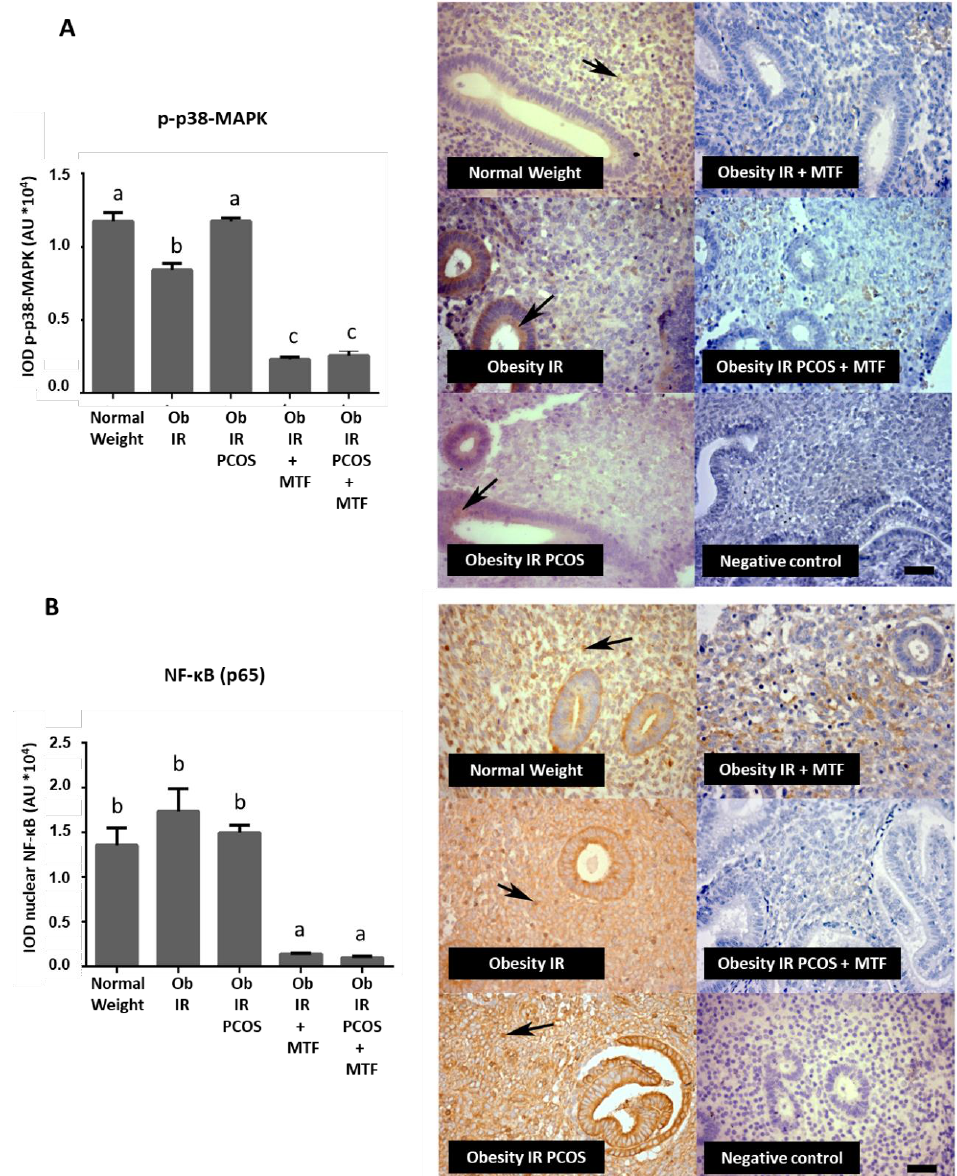
Figure 3. Effect of metformin on expression levels of p38-MAPK in its active form and NF-κB in the endometria of women with insulin resistance, obesity and PCOS. p-p38-MAPK (T180/Y182) protein (active form) ( A ) and NF-κB (p65 subunit) protein ( B ) levels in endometria from the study groups were determined by IHC ( n = 7 samples in each group): Normal Weight group (control group), Obesity+IR group, Obesity+IR+PCOS group, Obesity+IR group treated with metformin (MTF) and Obesity+IR+PCOS group treated with MTF. MTF treatment: 850 mg twice a day for at least 12 weeks. Photomicrographs show the tissue location of APPL1 (in ( A )) and APPL2 (in ( B )) by immune-posi- tive brown color staining in each sample (arrows). The graphs show the semi-quantification of each protein level in endometrial tissue obtained by the IOD tool. Negative control: tissue samples in the absence of primary antibody. Bar = 50 μm; images at 400× (in (A): image of 200× in inner box). In the graph, a ≠ b ≠ c indicates a statistically significant difference with a p -value < 0.05; non-parametric test and Dunn’s post hoc test. Data are shown as mean AU (arbitrary units *10 4 ) ± SEM.